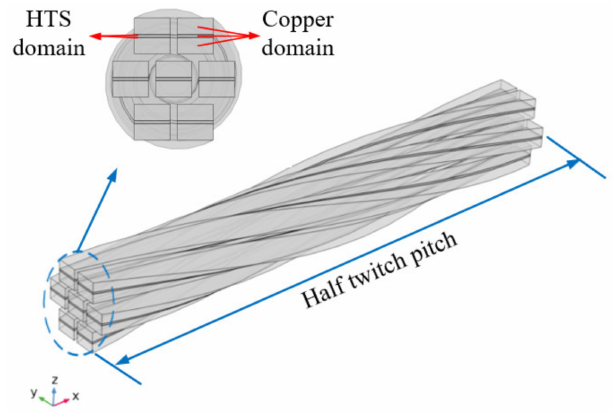
Figure 9. Three-dimensional geometric model of 2